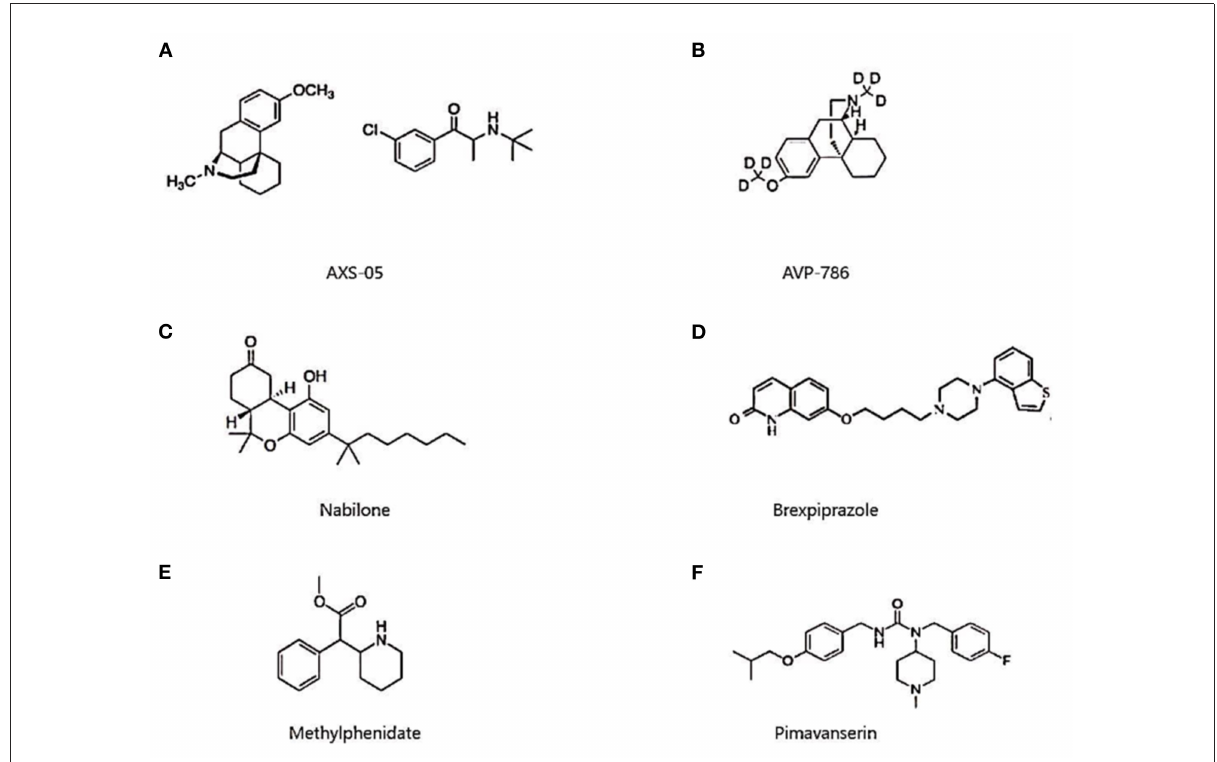
FIGURE4 Chemical structure of AXS-05 (A) , AVP-786 (B) , nabilone (C) , brexpiprazole (D) , methylphenidate (E) , and pimavanserin (F)